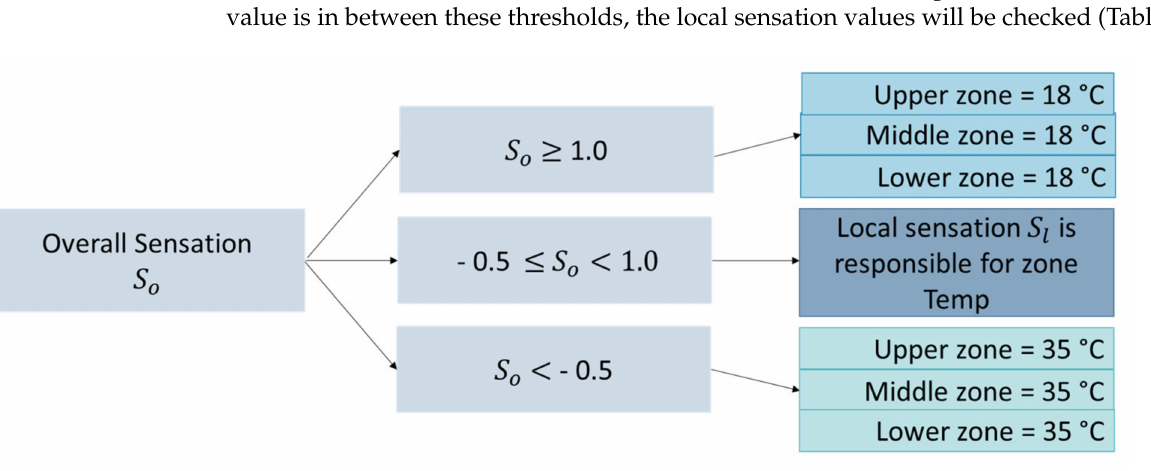
Figure 9. Control logic for the thermoelectric partition: the first step is the comparison of the overall sensation values with the sensation setpoints